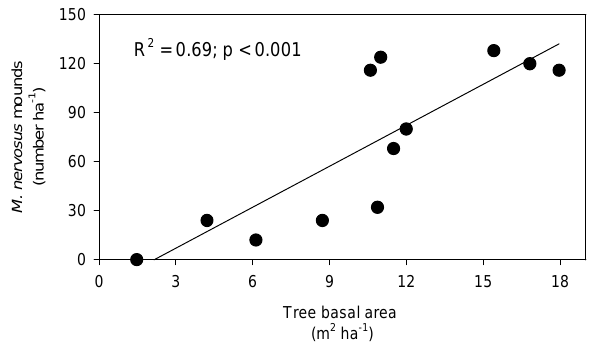
Tree basal area (m 2 ha -1